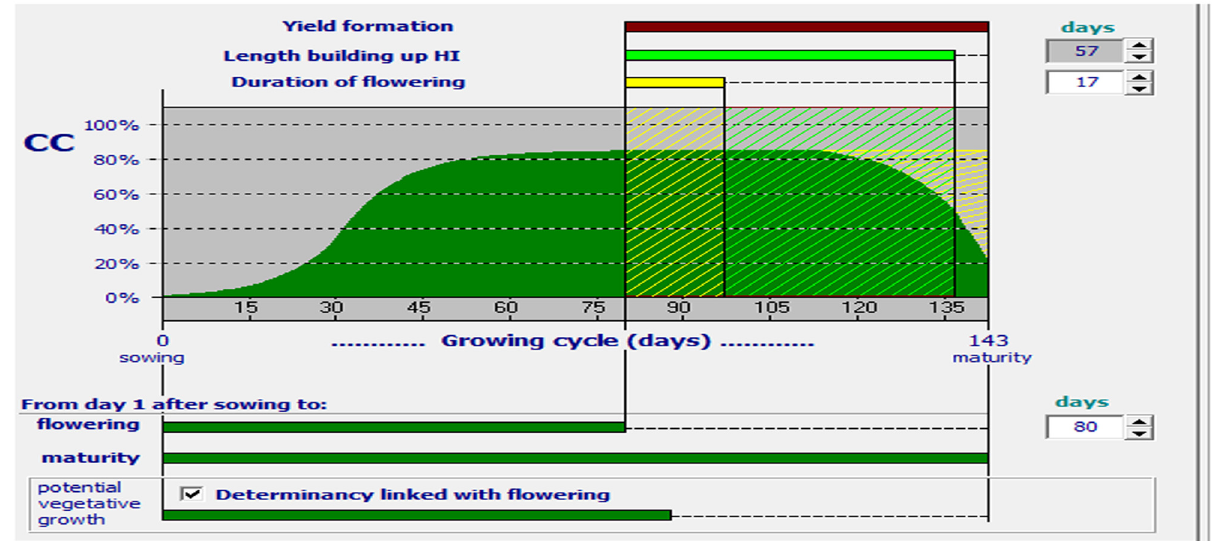
Figure 1: CC, fl owering and yield formation of wheat varieties by the Aquacrop